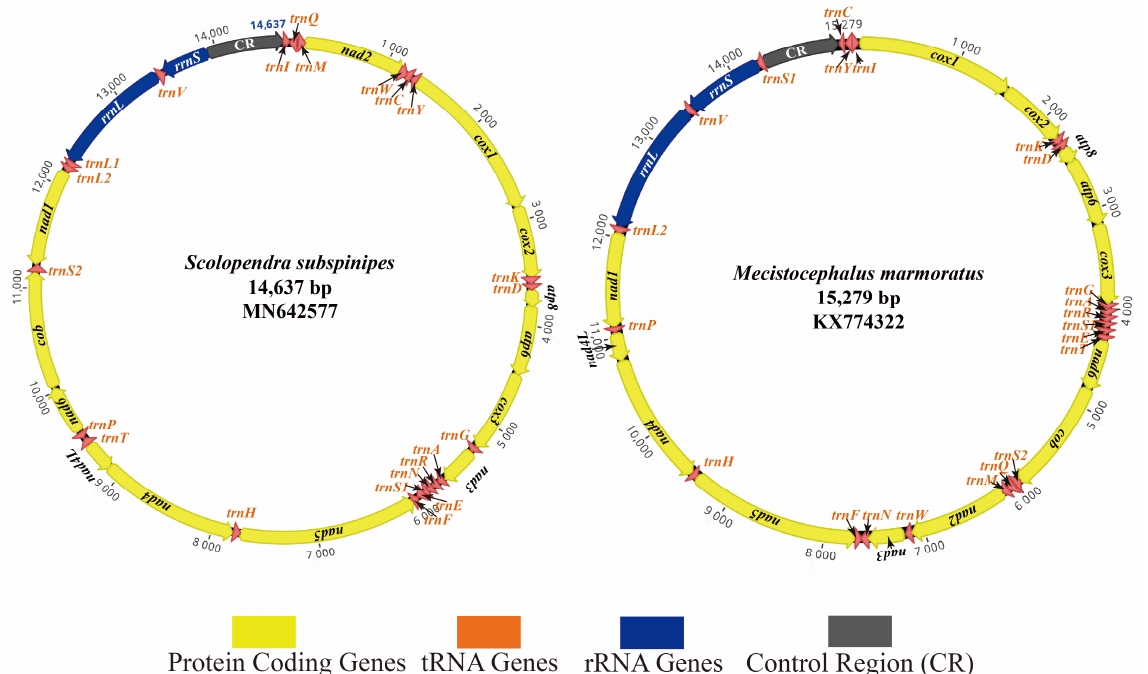
Figure 1. Circular map of the mitogenomes of S. subspinipes and M. marmoratus . Table 2. Nucleotide composition of the mitogenomes and protein-coding genes of Chilopoda. Mitochondrial Genome Species